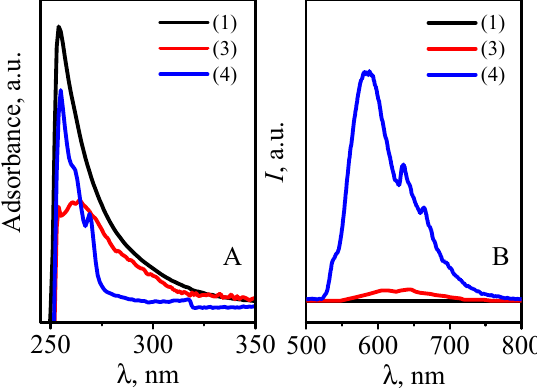
Figure 8. Excitation ( A ) and emission ( B ) spectra of the ligand 1 and Gd(III) 3 , Dy(III) 4 complexes at room temperature, c 1,3,4 = 1.0 × 10 − 4 mol ∙ L –1 .